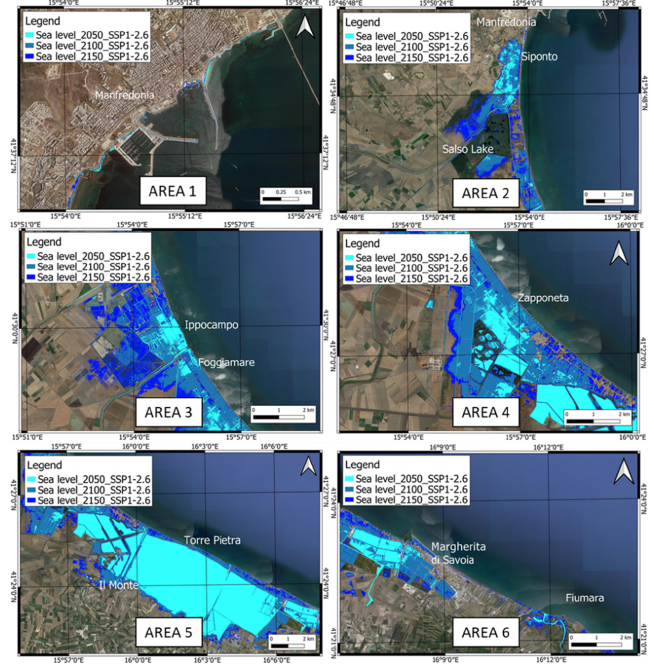
Figure 7. Expected RSLR scenario and coastline positions estimated for the low-emission scenario (SSP1-2.6—IPCC 2021) and current land subsidence for 2050, 2100, and 2150.